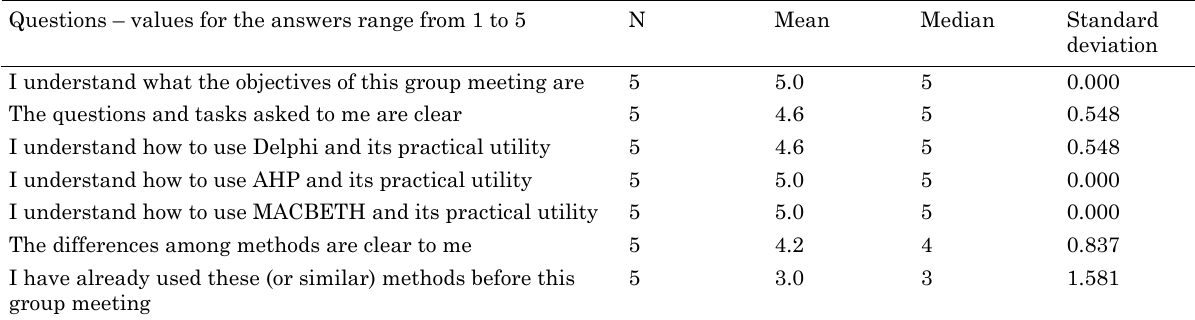
Table 7. Statistics of the pre-questionnaire Questions – values for the answers range from 1 to